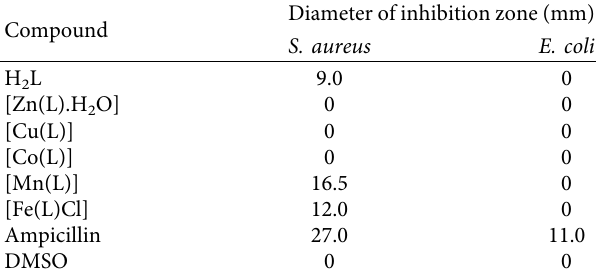
Table 1: Antibacterial activities of the unsymmetrical salen-type ligand and its metal complexes. Diameter of inhibition zone Compound